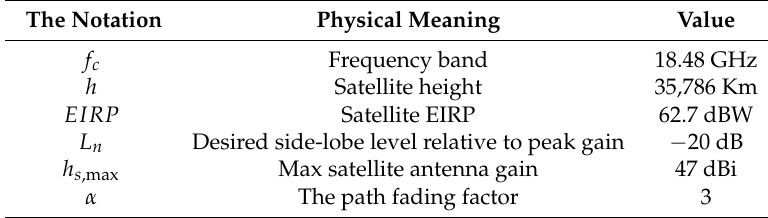
Table 1. Simulation